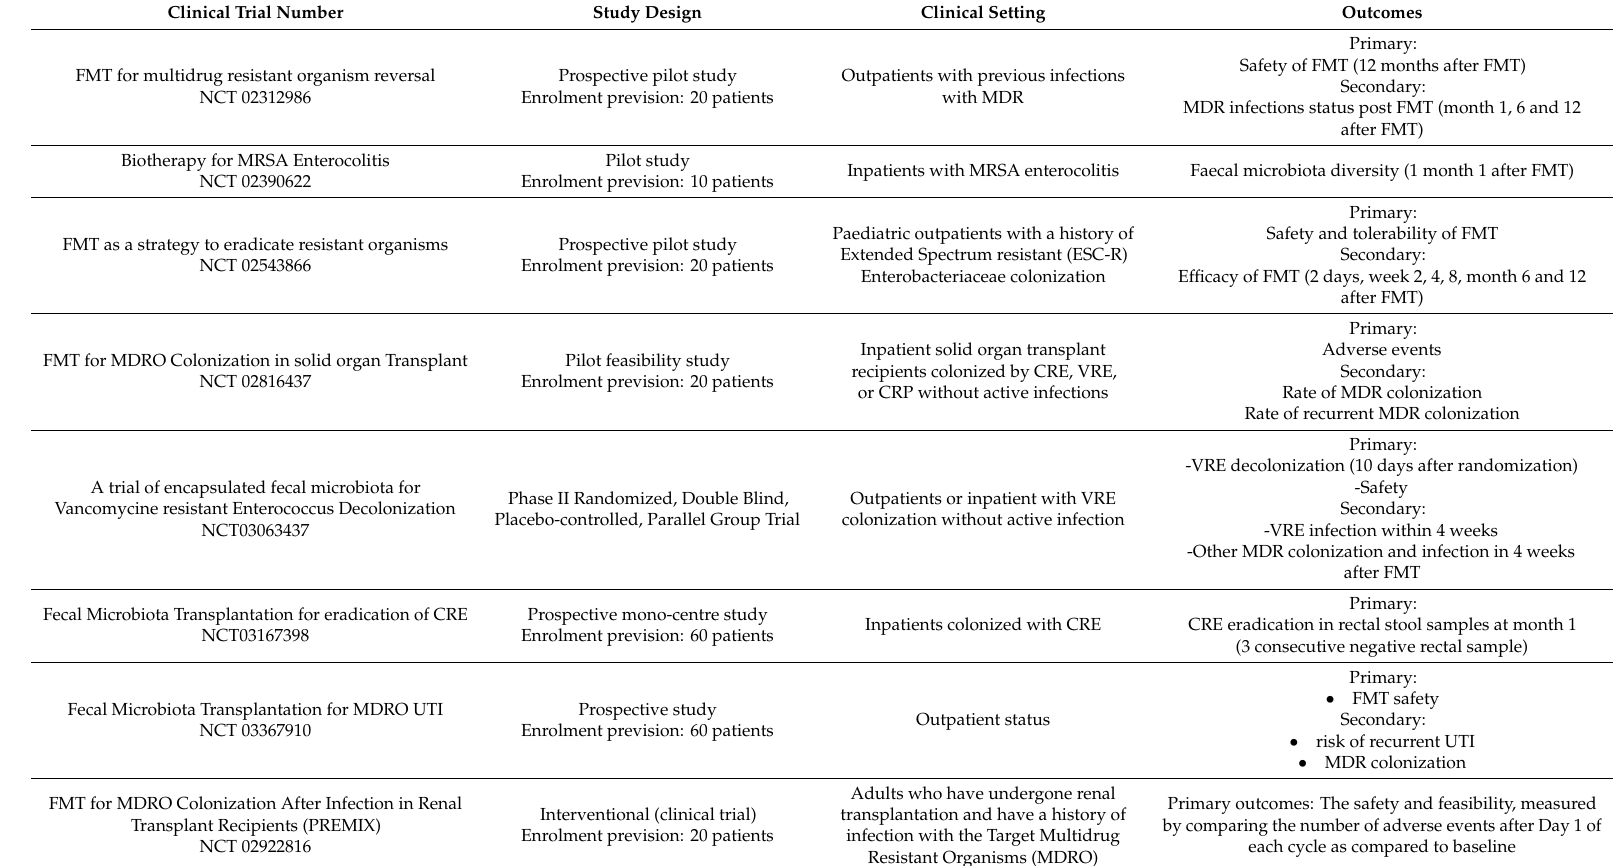
Table 3. Ongoing studies on FMT for MDR decolonization ((Clinicaltrials.gov), last access 30th June